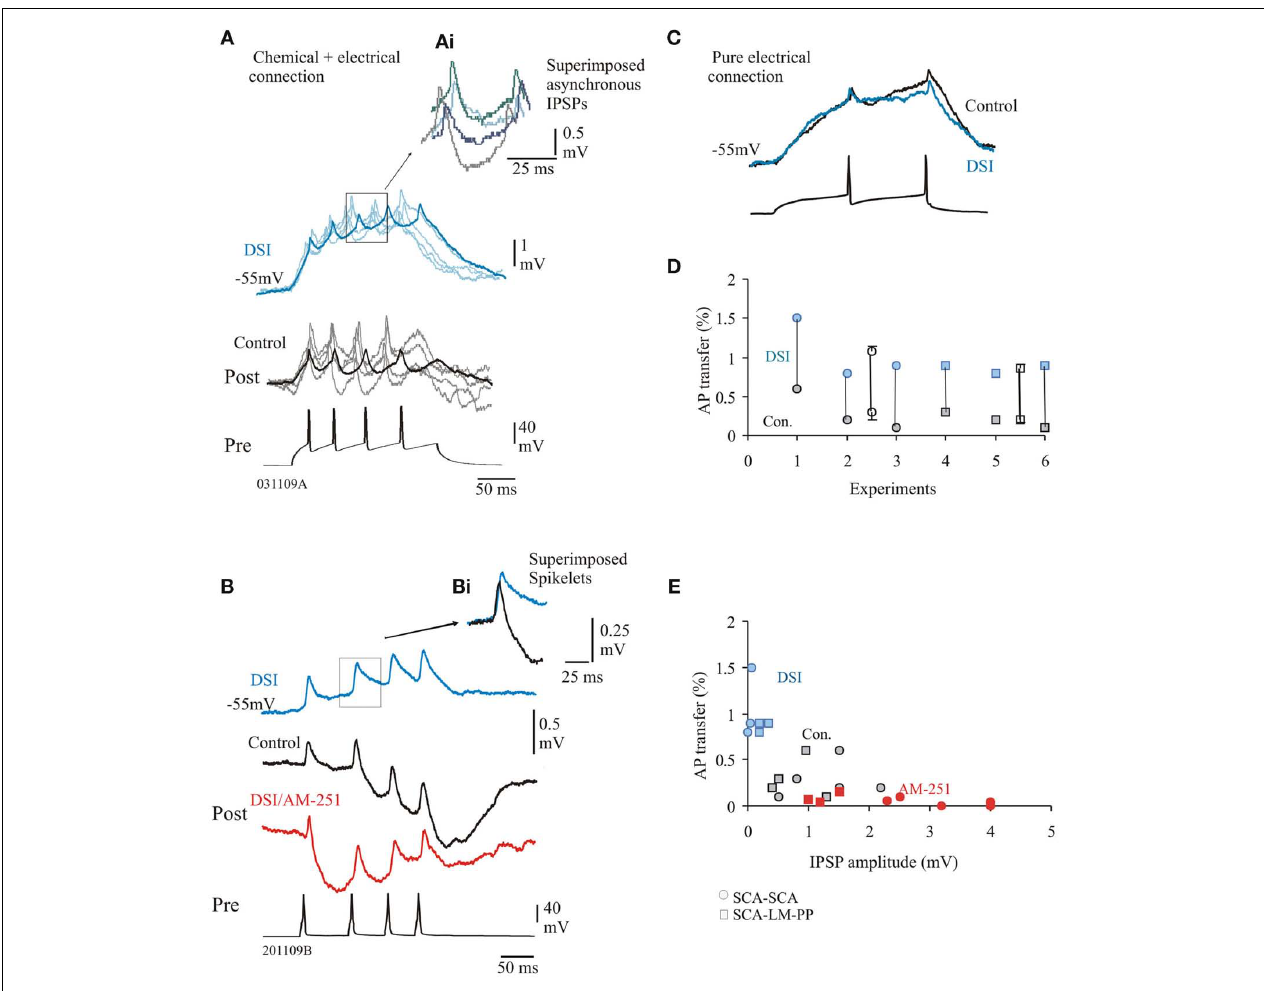
depression (see Ali, 2011, for further details). (Bi) Superimposed spikelets in control and DSI, enhanced transfer of amplitude and duration of the spikelets resulted during DSI. (C) SCA–SCA pair connected purely via electrical synapses. Averaged responses in control and during DSI are superimposed to illustrate that DSI did not enhance coupling coefficient at these synapses. (D) AP transfer in control and during DSI for individual pairs (average data ± SE are represented by empty symbols, x -axis represents individual pairs). (E) Plot of AP transfer and IPSP peak amplitudes, larger amplitude of the IPSPs (during AM-251, shown in red) was related to lower passive